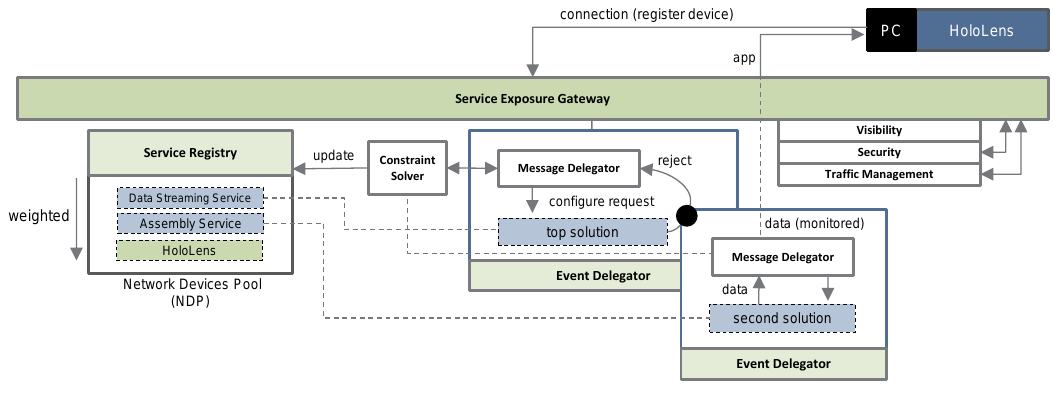
Figure 4. Self-configuration procedure for Microsoft